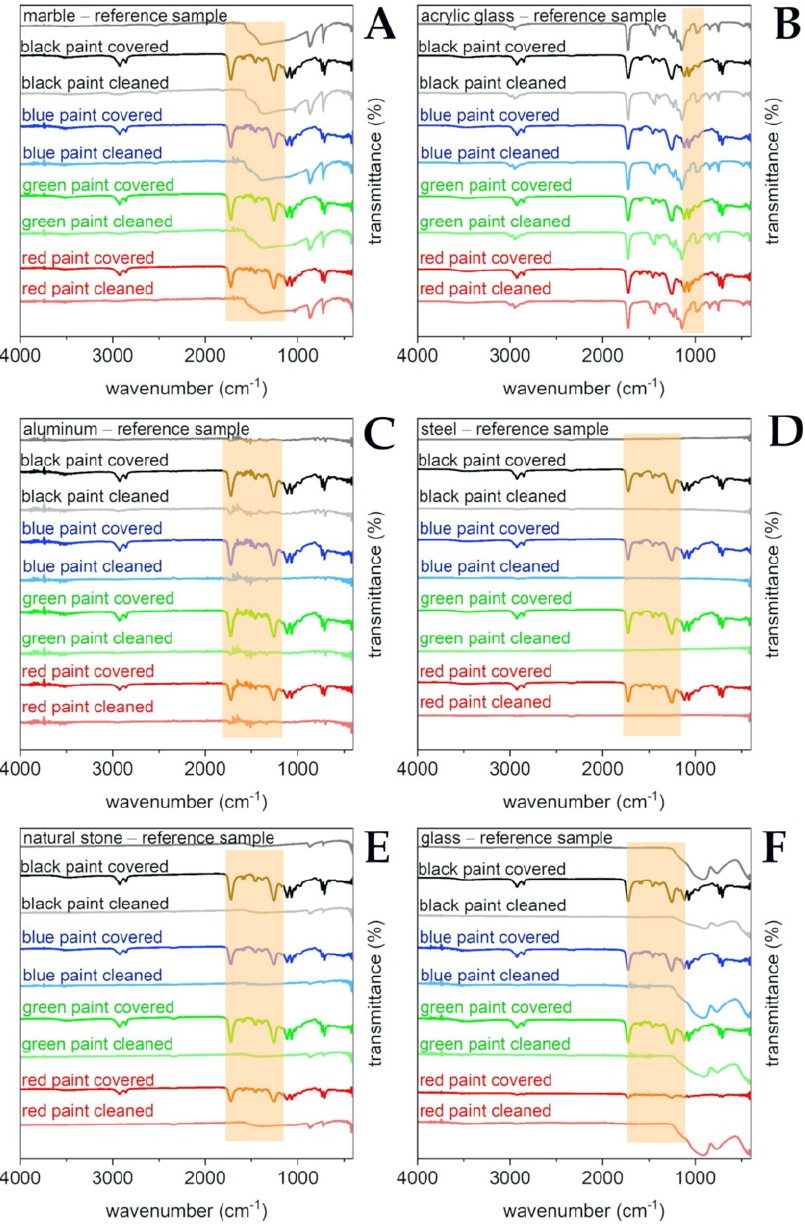
Figure 4. Results of selective laboratory paint removal tests on the selected substrates studied using ATR FT-IR spectral analysis. Reference materials and their samples covered with black, blue, green, and red paints together with the appropriate samples after cleaning procedures are shown in Figure 4A–F, respectively, in which: ( A )—marble; ( B )—acrylic glass; ( C )—aluminum, ( D )—steel; ( E )—natural stone; ( F )—glass.